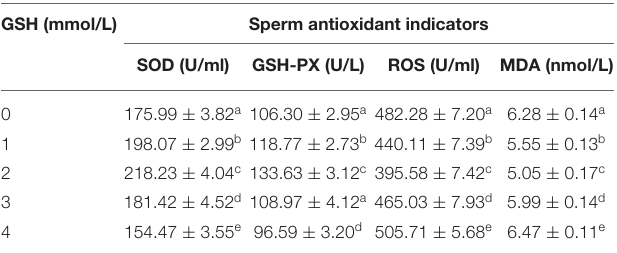
TABLE 4 | Effect of glutathione (2 mmol/L) on in vitro fertilization and embryo development of dairy goat